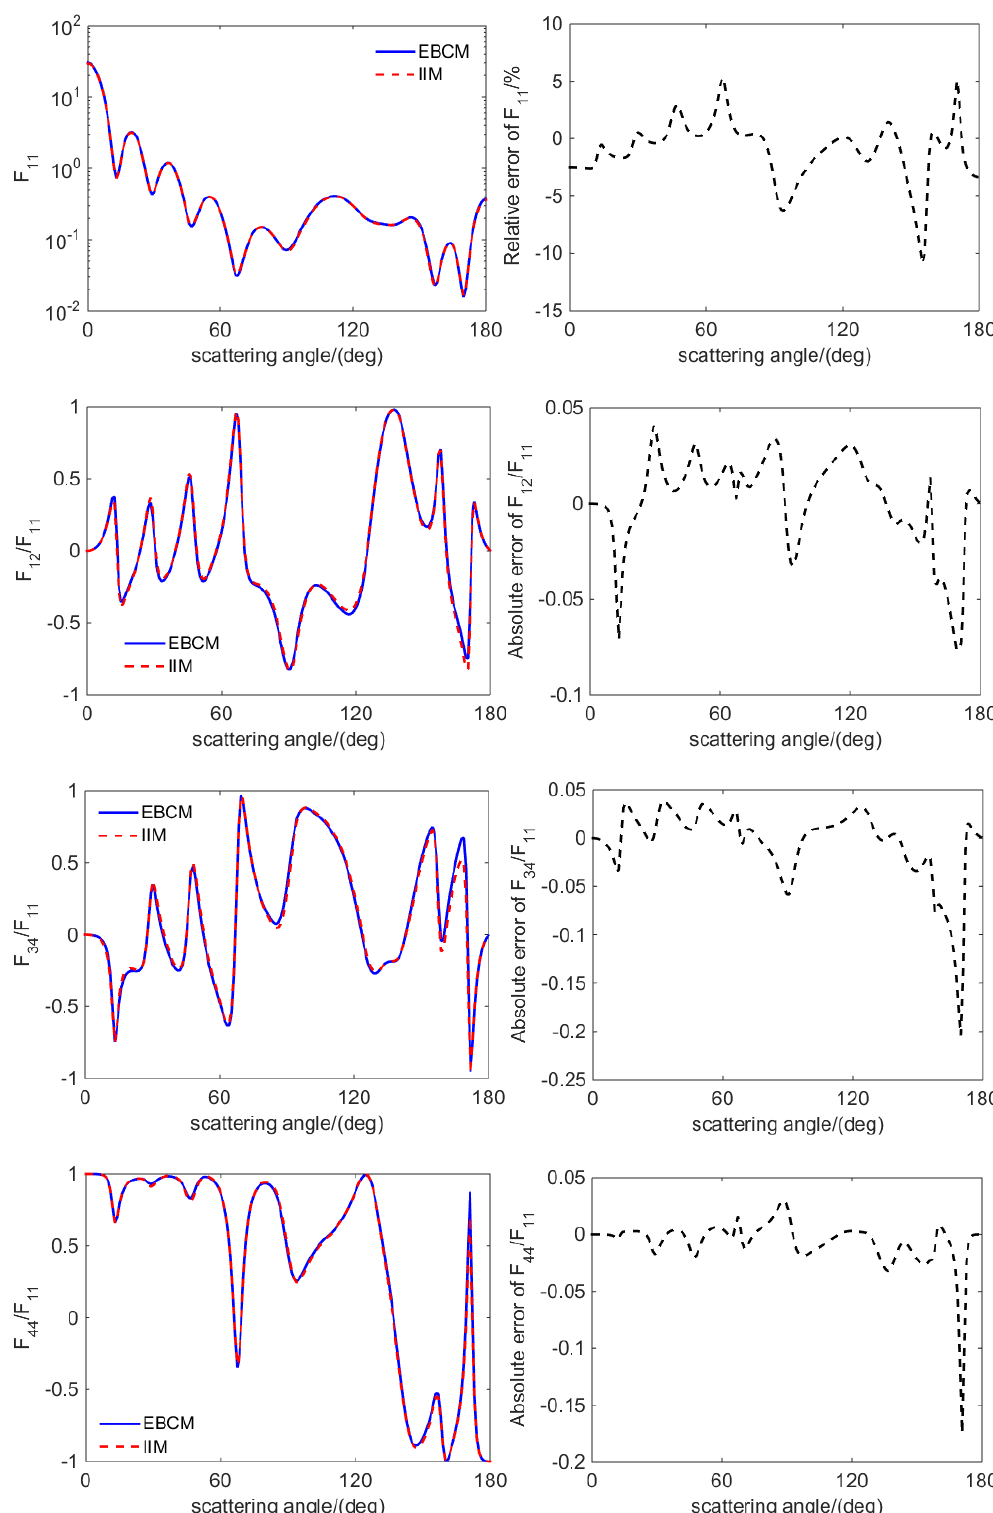
Figure 4. The scattering phase matrix obtained by the IIM and Extended Boundary Condition Method (EBCM) T-Matrix methods for small spheroid particles. The simulation errors of F 11 are denoted by relative errors. For F 12 , F 34 , and F 44 , they are firstly normalized by F 11 , and their simulation errors are evaluated by the absolute errors.